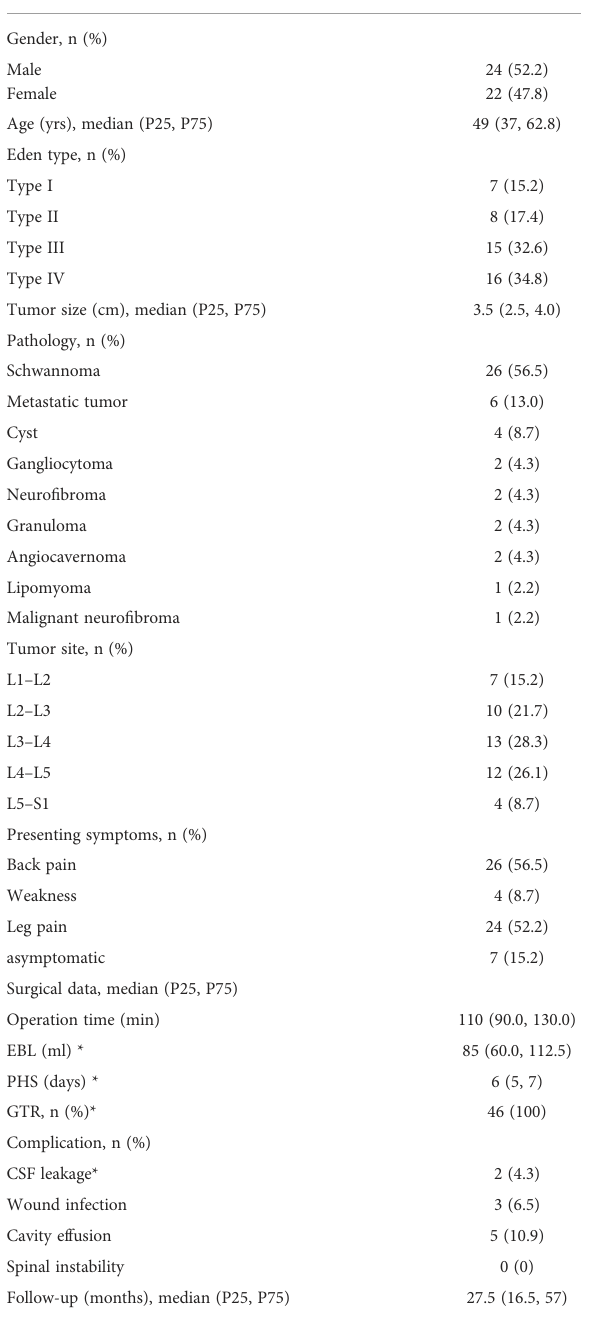
TABLE 1 Clinical data of patients